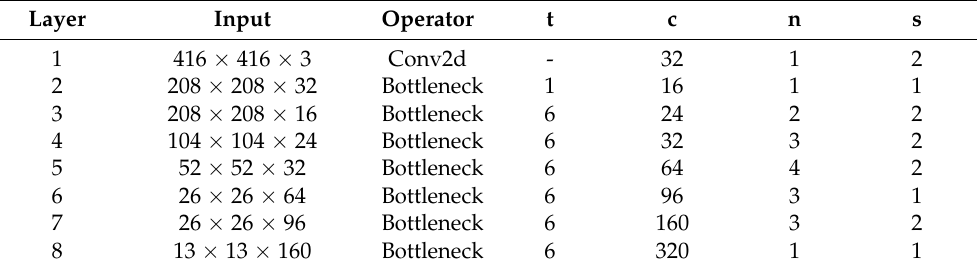
Table 1. Modified MobileNetv2 network structure by layer.